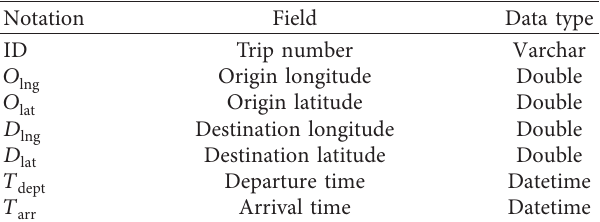
Table 1: Origin-destination data